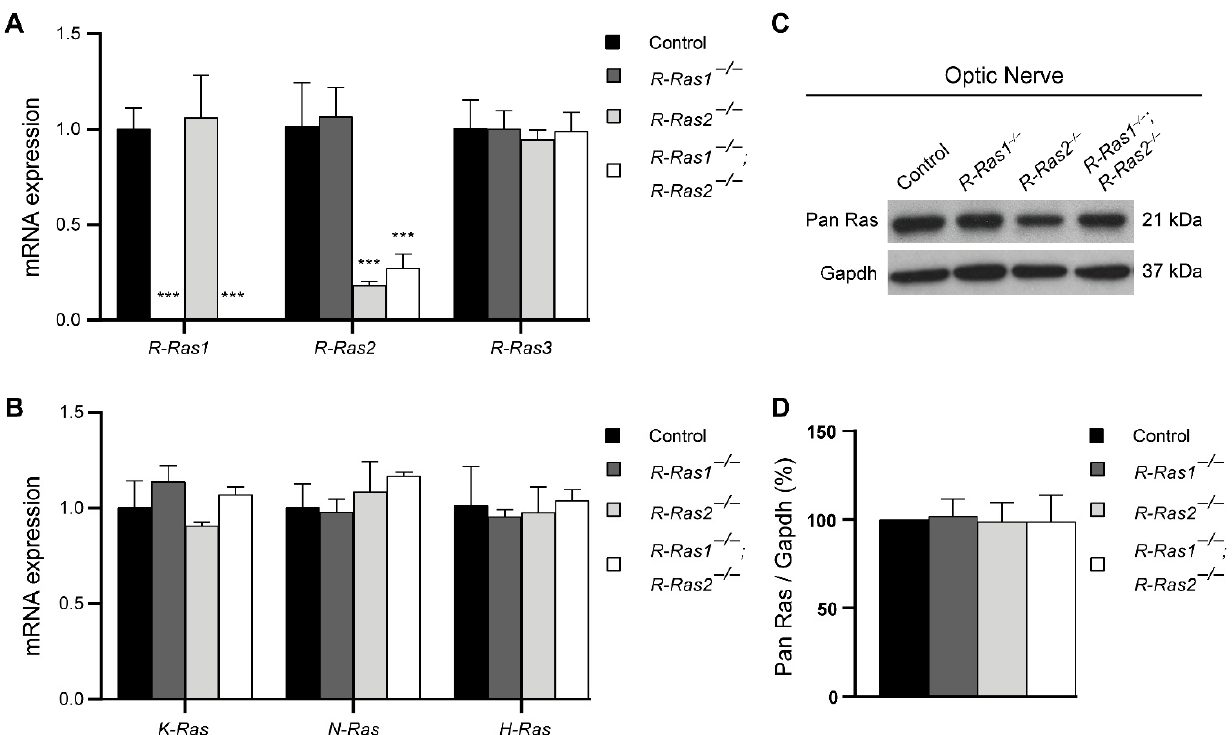
Figure 1. Absence of R-Ras1 and/or R-Ras2 does not modify R-Ras3 or classical Ras expression. ( A ) RT-qPCR experiments display relative expression of R-Ras1 , R-Ras2 , and R-Ras3 in optic nerves from control, R-Ras1 − / − , R-Ras2 − / − , and R-Ras1 − / − ; R- Ras2 − / − adult mice (P90). R-Ras1 mRNA expression showed significant differences in the R-Ras1 − / − (*** p < 0.001) and R- Ras1 − / − ;R-Ras2 − / − mice (*** p < 0.001). R-Ras2 mRNA expression showed significant differences in the R-Ras2 − / − (*** p < 0.001) and R-Ras1 − / − ; R-Ras2 − / − mice (*** p < 0.001). No significant differences were observed in the expression of R-Ras3 in the mutants relative to controls. ( B ) RT-qPCR experiments display relative expression of K-Ras , N-Ras , and H-Ras in ONs from control, R-Ras1 − / − , R-Ras2 − / − , and R-Ras1 − / − ; R-Ras2 − / − adult mice (P90). No significant differences were observed in the